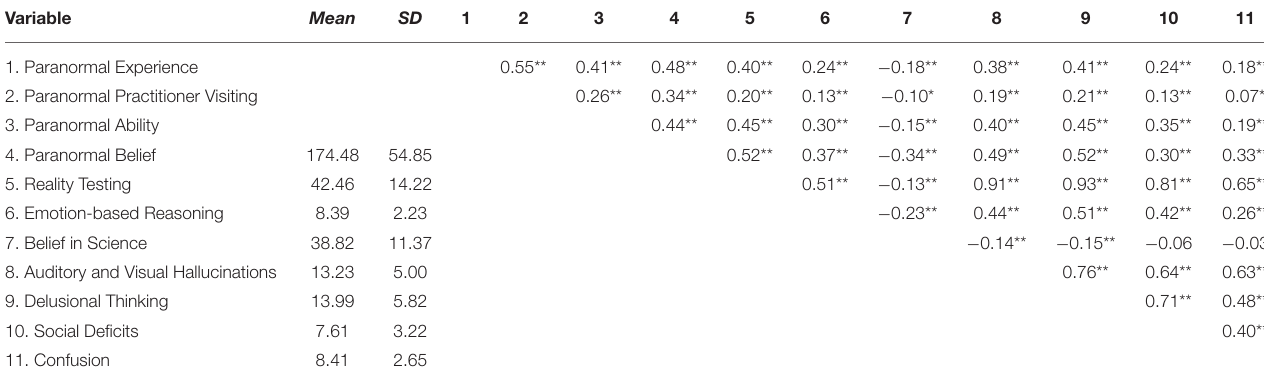
TABLE 1 | Descriptive statistics and intercorrelations among all study variables. Variable